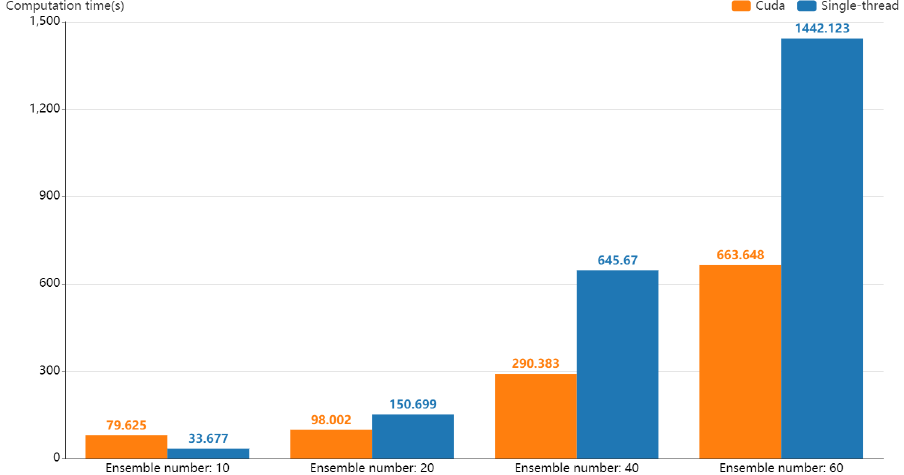
Figure 15. Computation time of DG synthetic data set with different ensemble numbers using CUDA implementation and single-thread implementation.